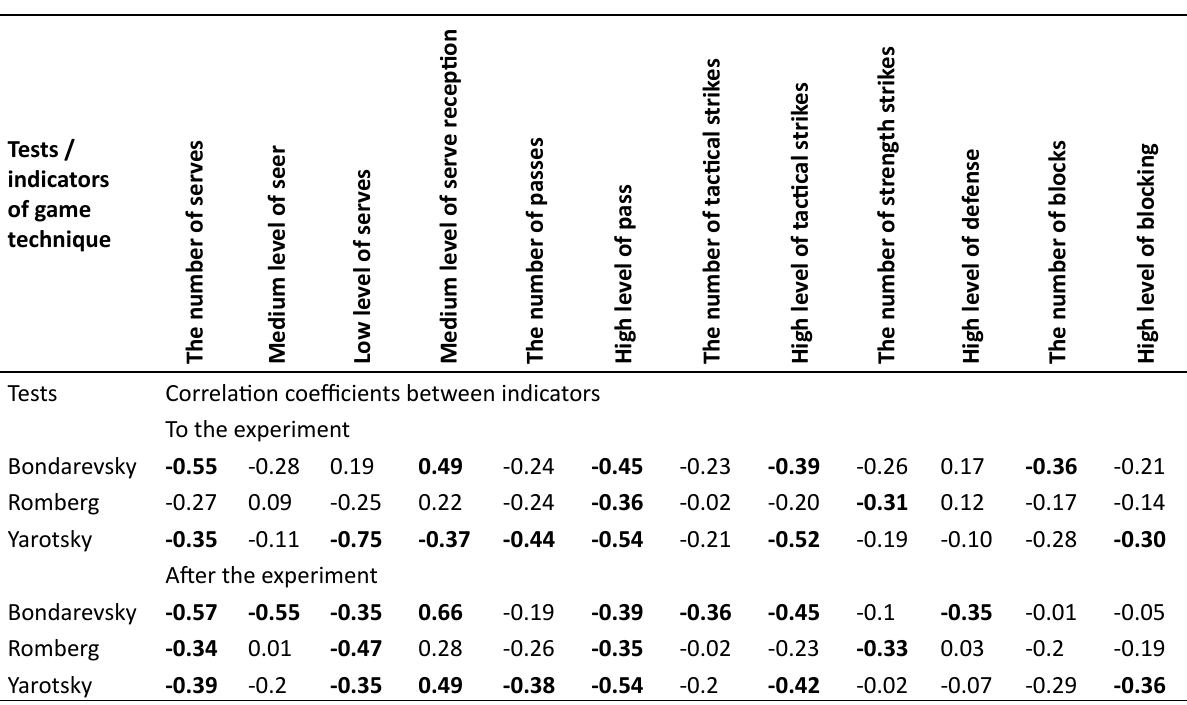
Table 2. Influence of the level of static balance on the indicators of competitive activity of athletes aged 17-21 (n = 20)